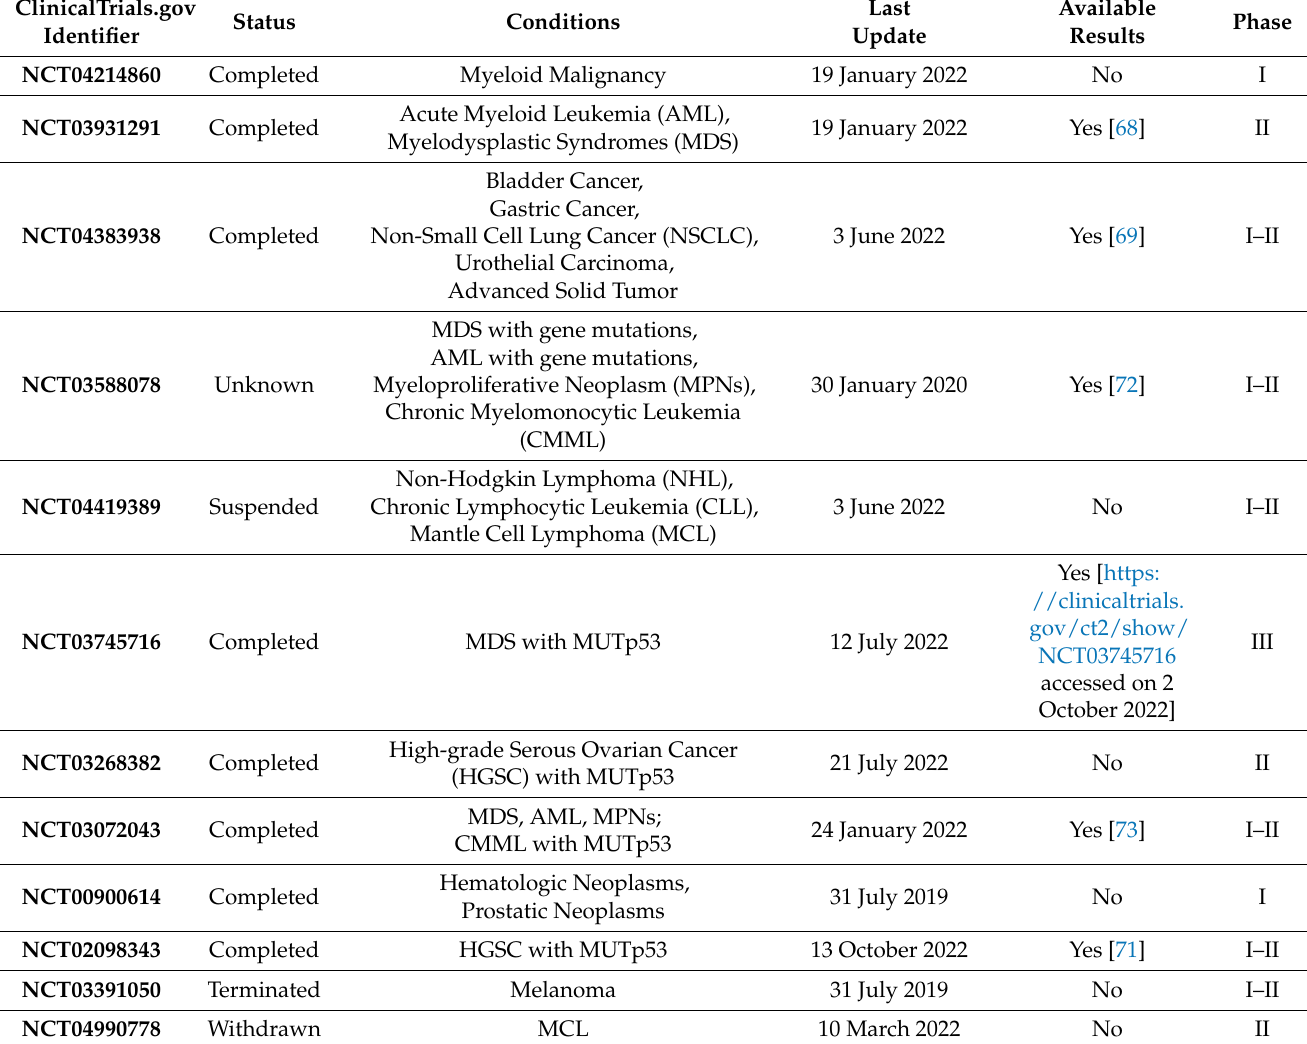
Table 2. Currently registered clinical trials for the use of APR-246 in oncology